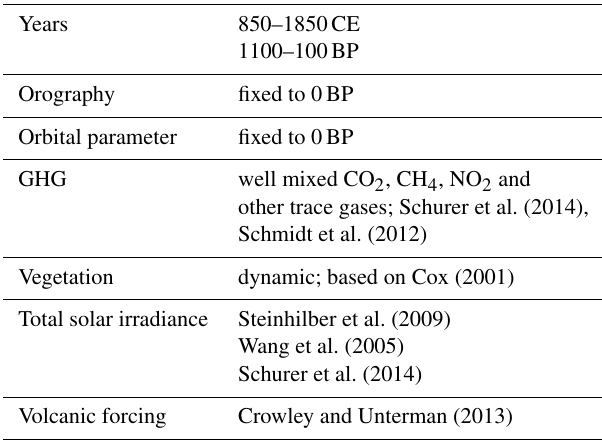
Table 1. Basic characterization of the LM1, LM2, and LM3 last- millennium